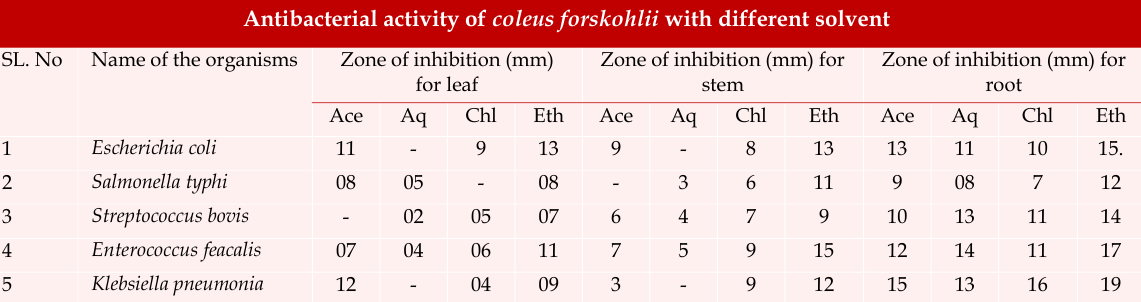
Antibacterial activity of coleus forskohlii with different solvent SL.